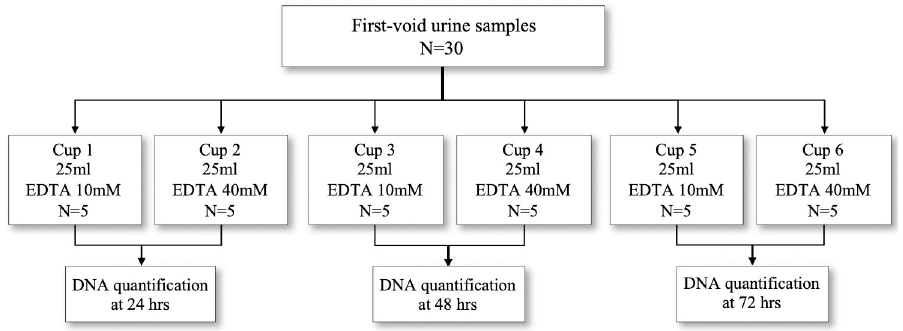
Fig 2. Overview of urine sample collection and processing of second evaluation. Separating samples into two groups with different EDTA concentrations, further divided to examine different lengths of time from urine specimen collection to time of specimen processing. This evaluation was performed as a set of urine samples from five volunteer women, who collected a first-morning, first-void urine sample, in six different cups (25ml each). Three cups contained 10mM EDTA while the other three cups contained 40mM. Samples were then processed at 24, 48 and 72 hours as shown.